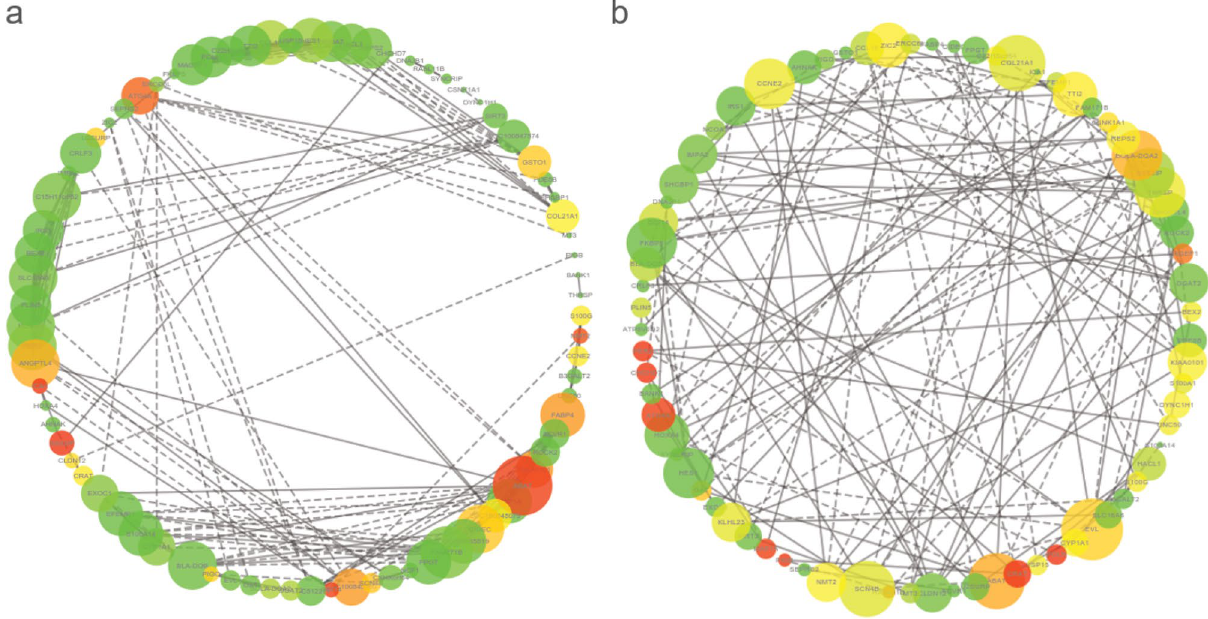
Figure 3. Co-expression analysis in bulls ( a ) and steers ( b ). Red indicates crucial nodes in the network, followed by orange and yellow; Green indicates a minimum contribution degree and low-value in the network; solid and dotted indicate pos- and neg-correlations, respectively.